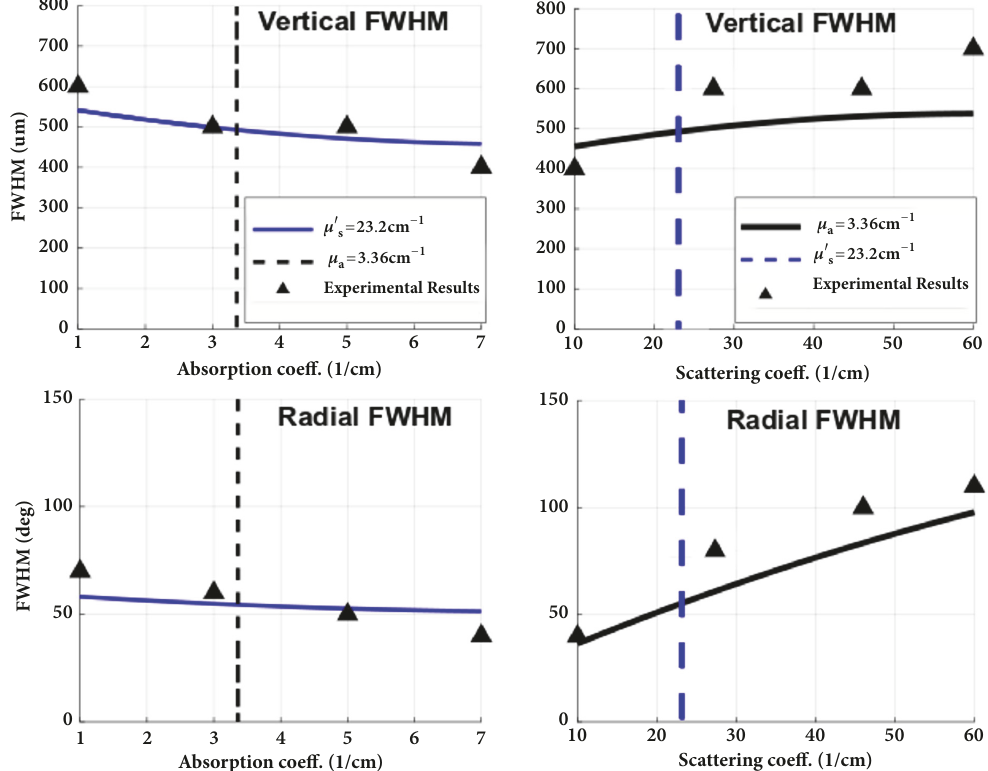
Figure 4: Results from phantom experiments compared to simulations measuring resolution in vertical and radial direction. For the absorption coefficient, 𝜇 𝑎 , four data points were collected at 1.0, 3.0, 5.0, 7.0 cm −1 . Our estimation for the value of 𝜇 𝑎 in brain tissue is 3.36 cm −1 . Phantom results are within 20% of our simulations (Left). For the reduced scattering, 𝜇 󸀠 𝑠 , four data points at 10.0, 26.0, 43.0, 60.0 cm −1 were collected. The value of 𝜇 󸀠 𝑠 we used for simulations was 23.2 cm −1 . These results are within 25% of the simulated values for the